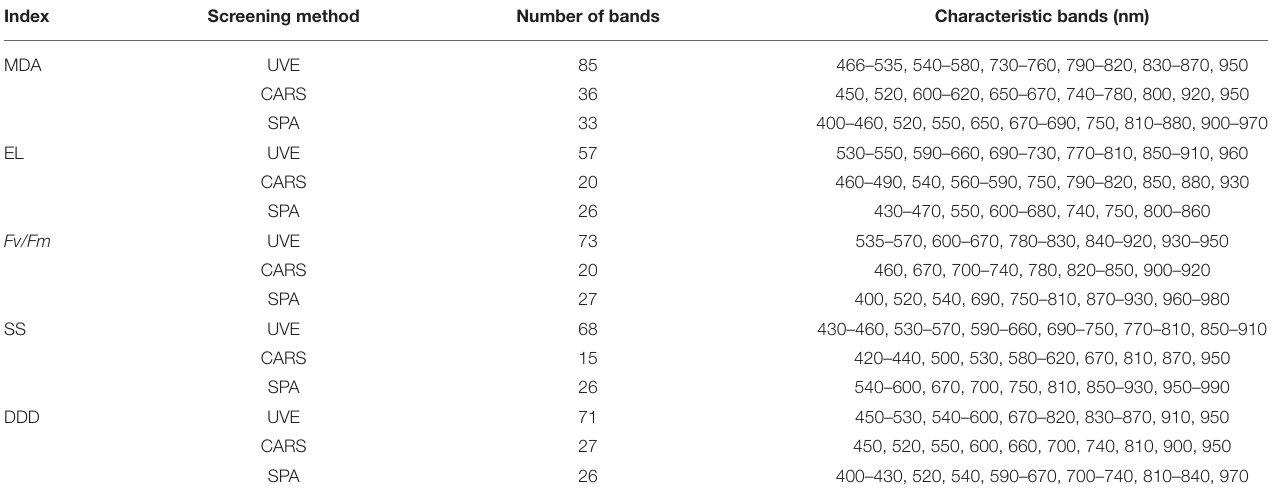
TABLE 2 | Bands screening results.